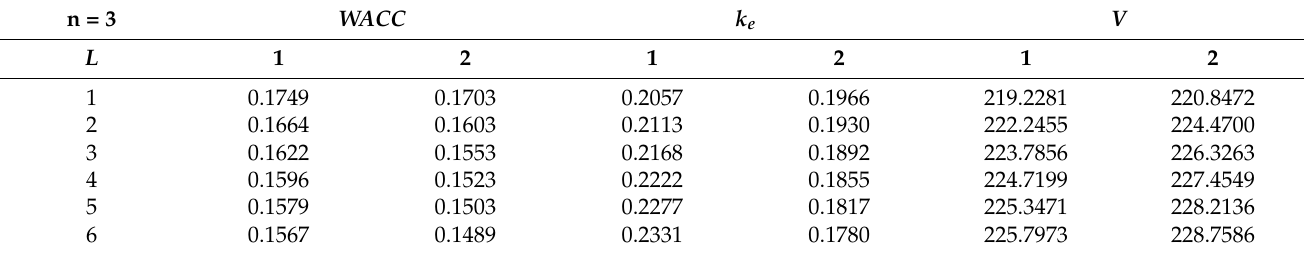
Table 1. Dependence of the weighted average cost of capital, WACC , equity cost, k e and company value, V , on leverage level L in the cases of payments of tax on profit at the end of the year (1) and in the beginning of the year (2) for three-year